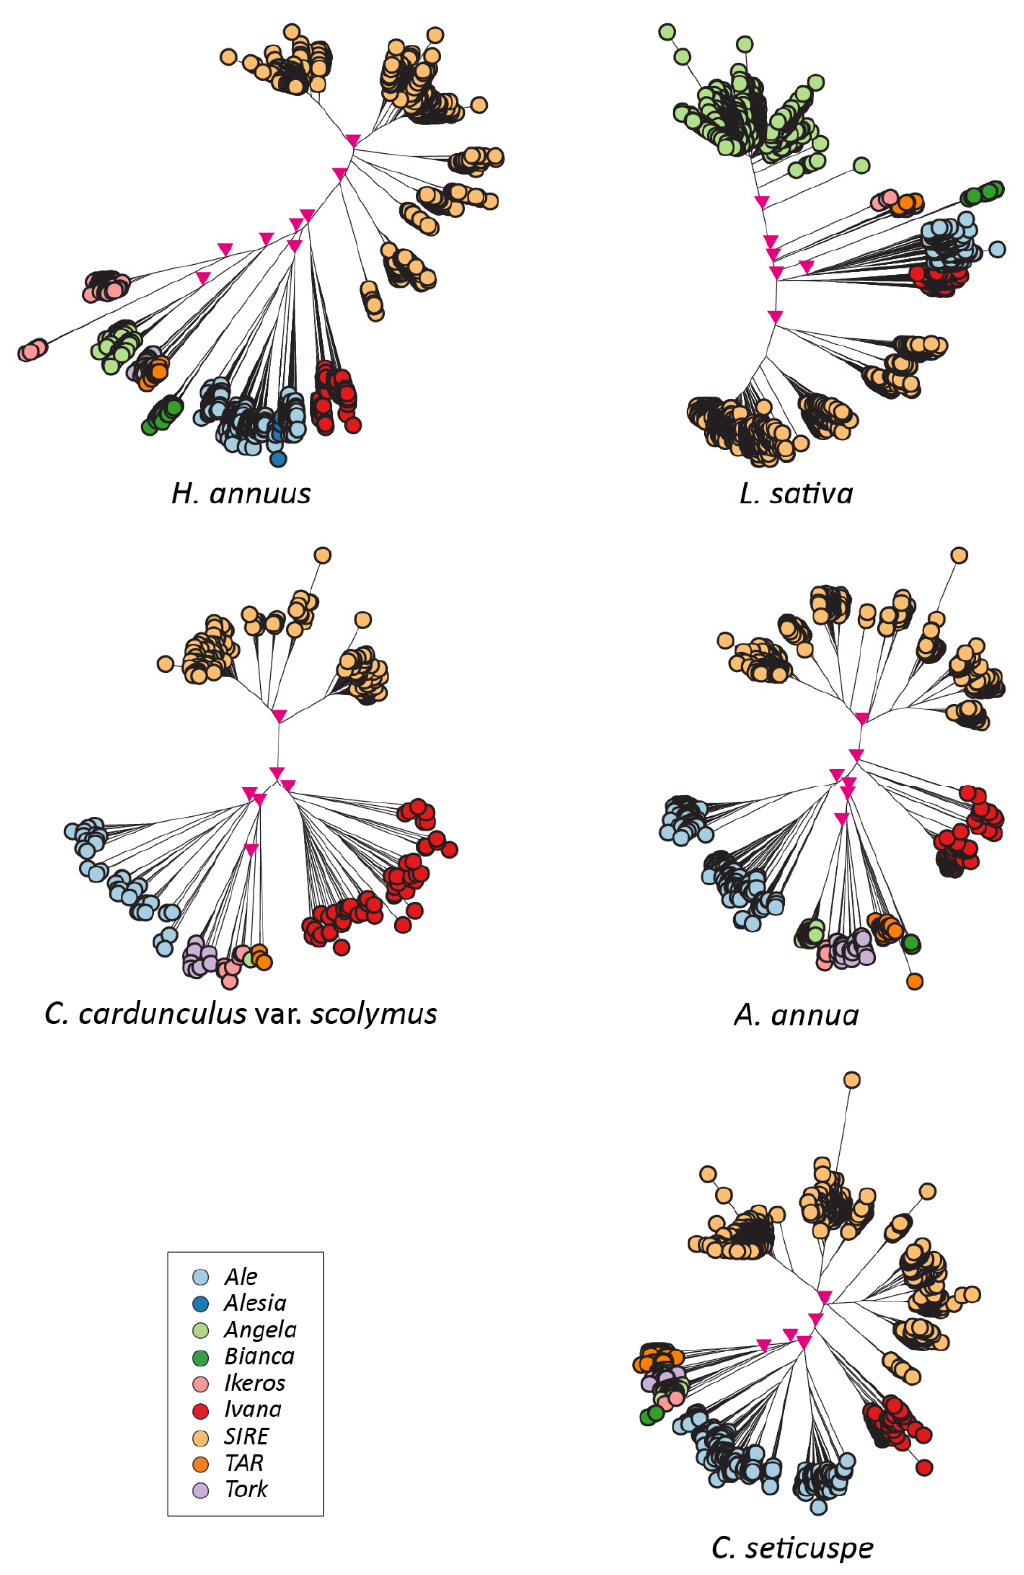
Figure 4. Phylogenetic trees of the LTR-REs of the Copia superfamily in individual species. The main nodes (bootstrap values > 0.6) separating the lineages are marked with pink triangles.